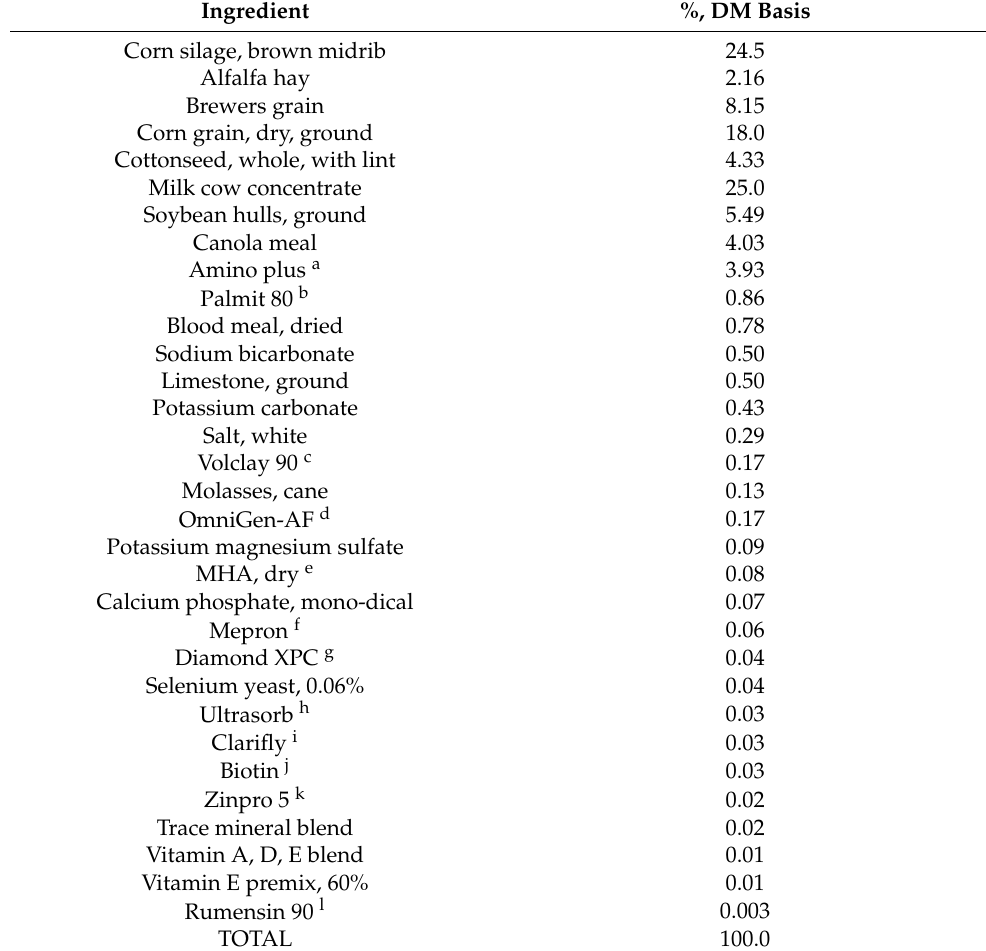
Table 1. Formulated composition of the common TMR fed to all treatment groups 1